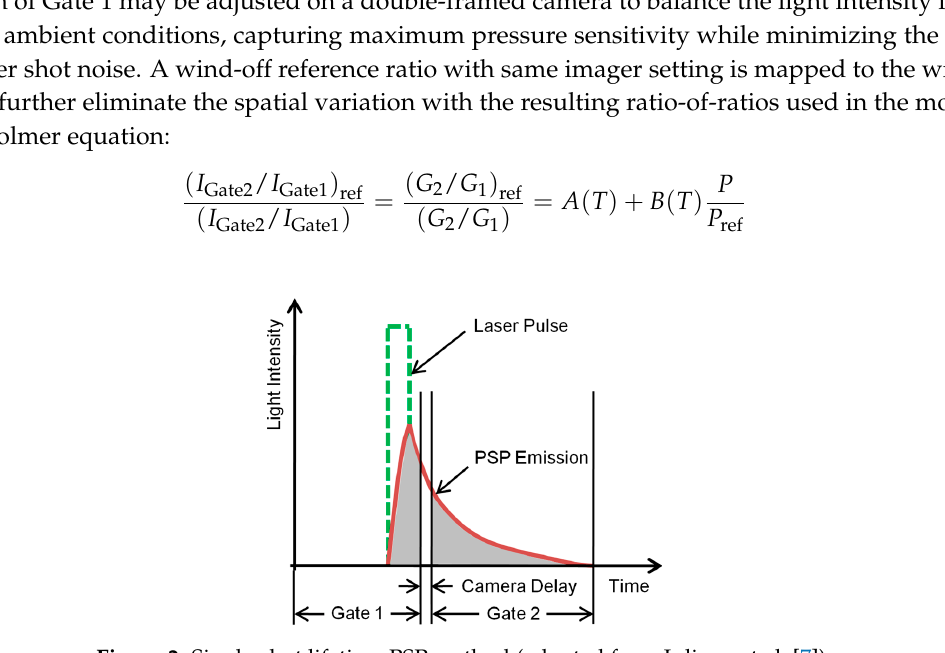
Figure 2. Single-shot lifetime PSP method (adapted from Juliano et al. [7]).